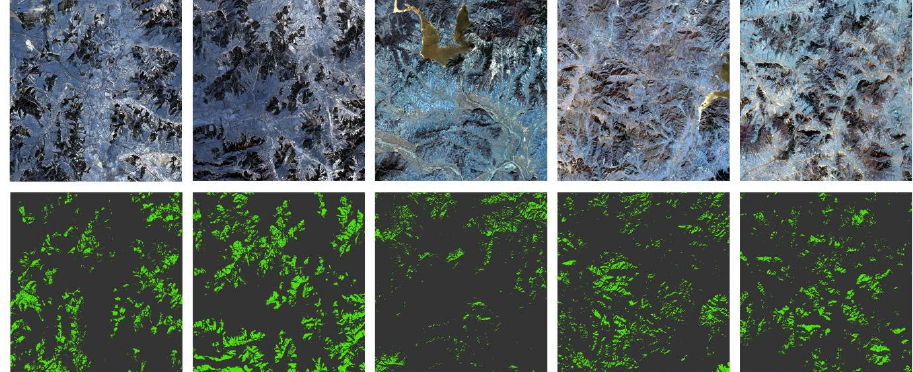
Figure 4. Example of training and validation sample blocks. The first row shows five Landsat images in 2020. The second row shows the labels corresponding to the first row, which were generated by using Sentinel-2 A/B images, SVM classifier and post-processing. The coniferous forests are shown in green, and the other land types are shown in black.